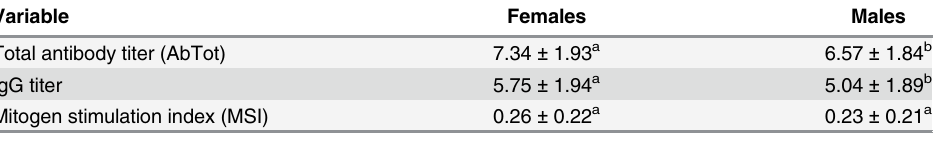
Table 1. Gender differences in total antibody (AbTot) and IgG titers, and mitogen stimulation index (MSI) after non-infectious challenges with sheep red blood cells (SRBC) and phytohemagglutinin (PHA), respectively. Values are expressed as means ± standard deviation: titer as log 2 of the reciprocal of the greatest dilution causing visible hemagglutination; skin thickness in cm. Variable